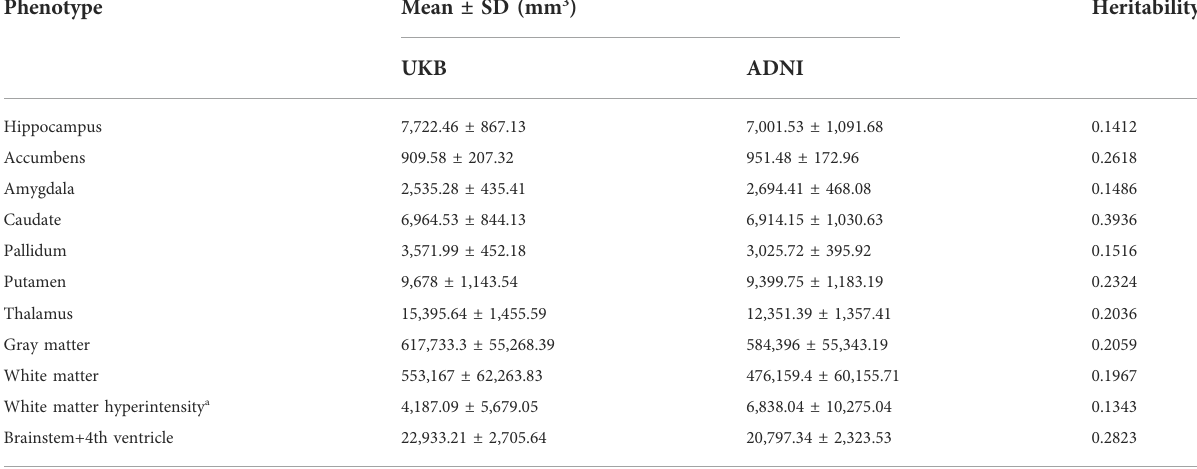
TABLE 2 The distributions of eleven brain imaging traits in UKB and ADNI as well as their heritability based on UKB.